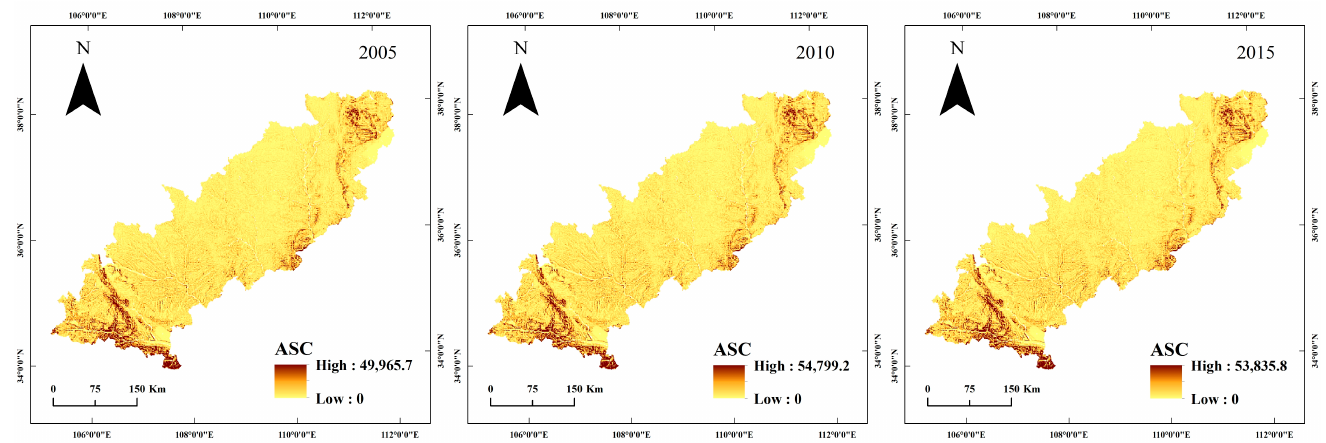
Figure 14. Distribution of soil conservation services in the Loess Plateau Ecological Screen from 2005 to 2015.